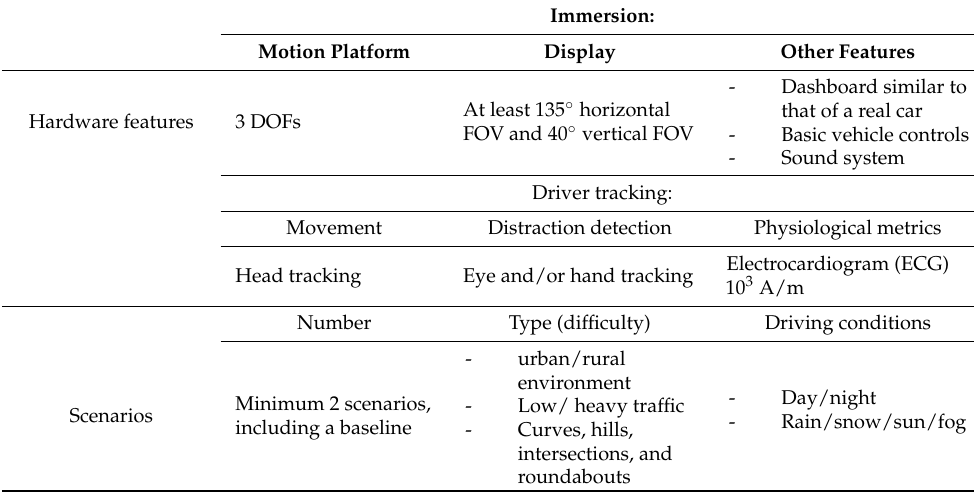
Table 1. Minimum feature recommendations for experiments using a driving simulator. Immersion: Motion Platform Display Other